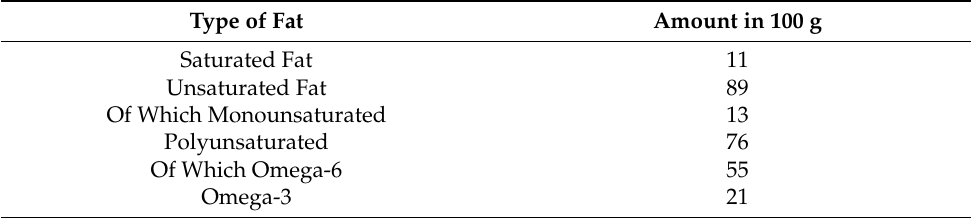
Table 2. Hemp seed oil